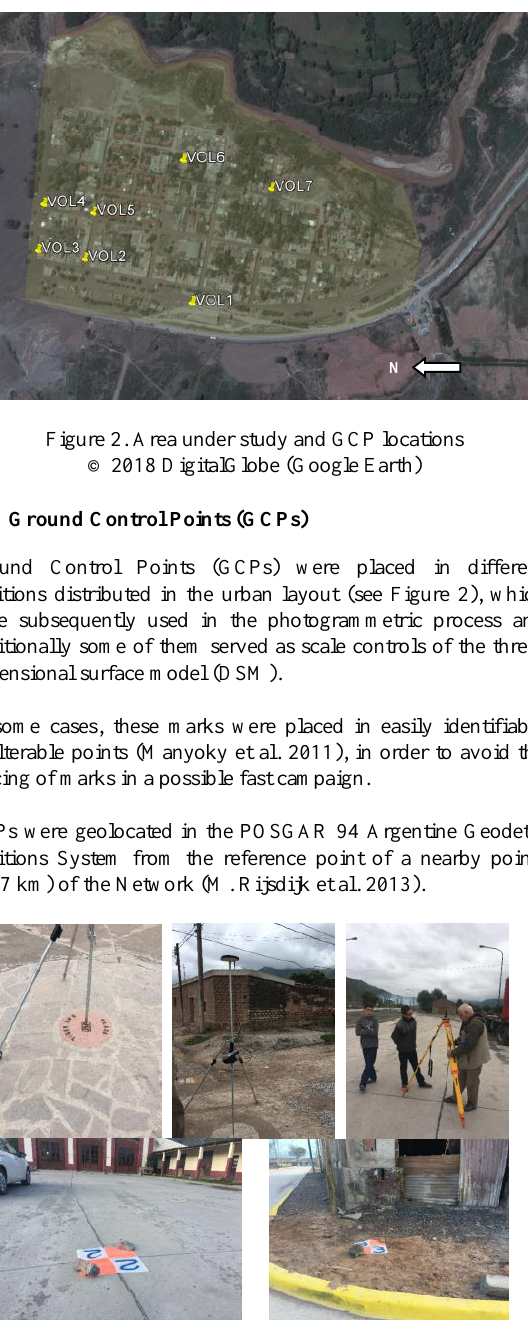
Figure 3. GCPs, Measurement and